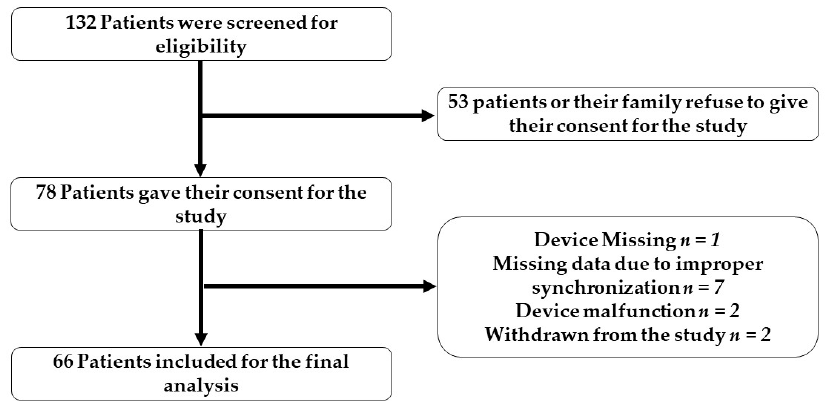
Figure 4. Flowchart of patient enrollment process.